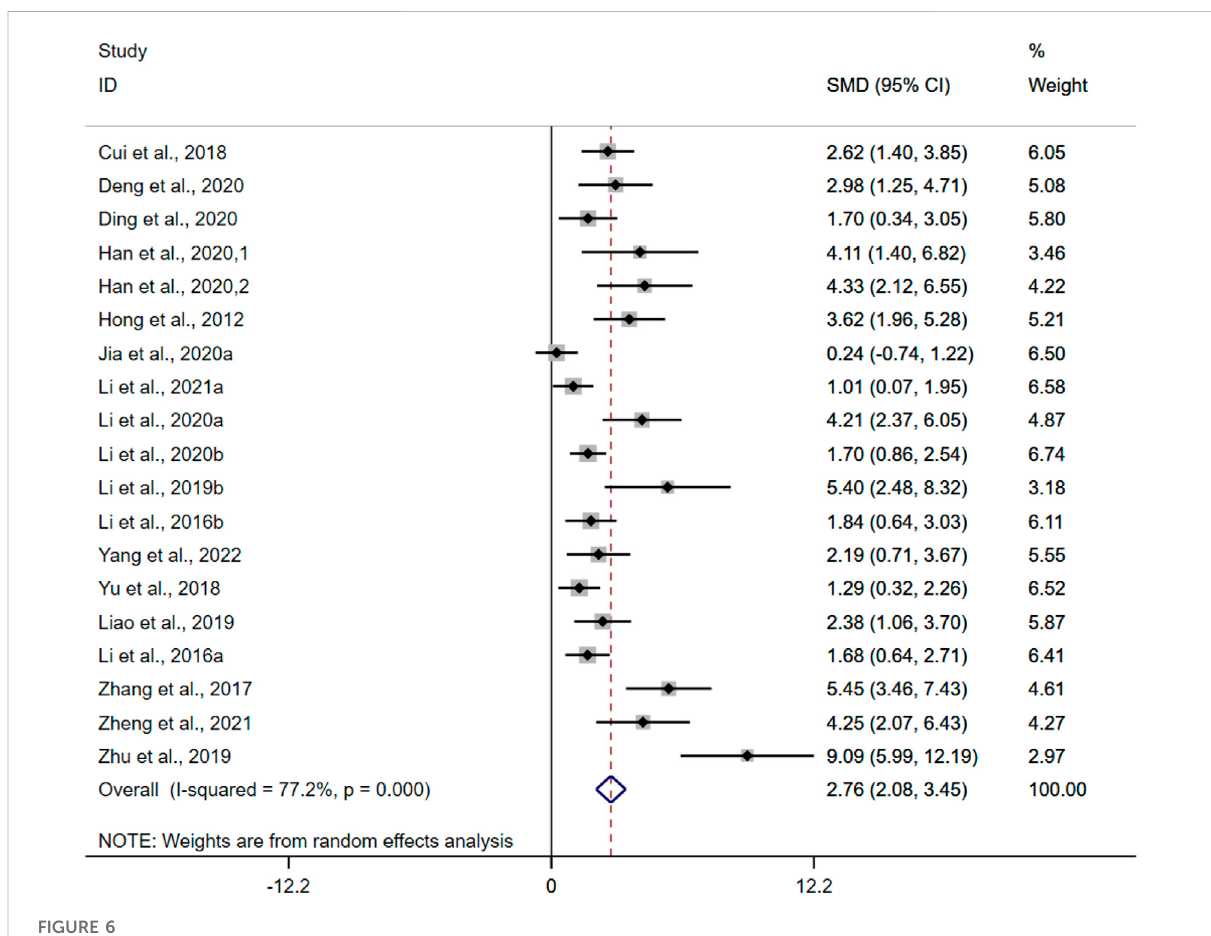
FIGURE 6 Forest plot: effect of berberine on CL